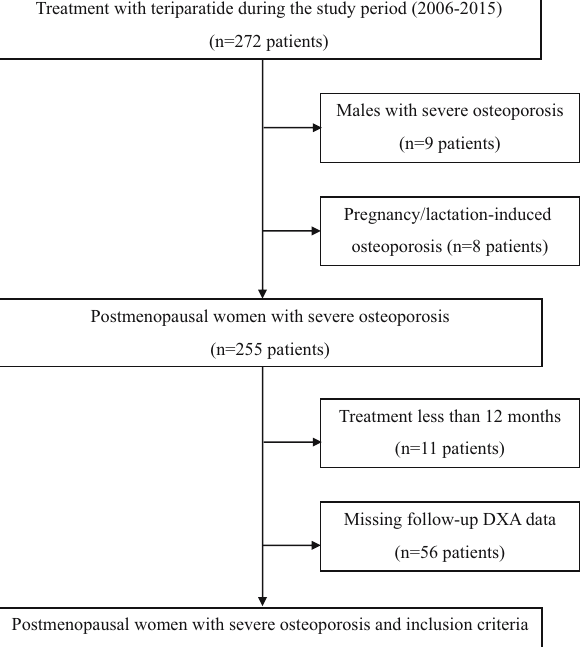
Figure 1: Study design. Notes. DXA – dual - energy X - ray